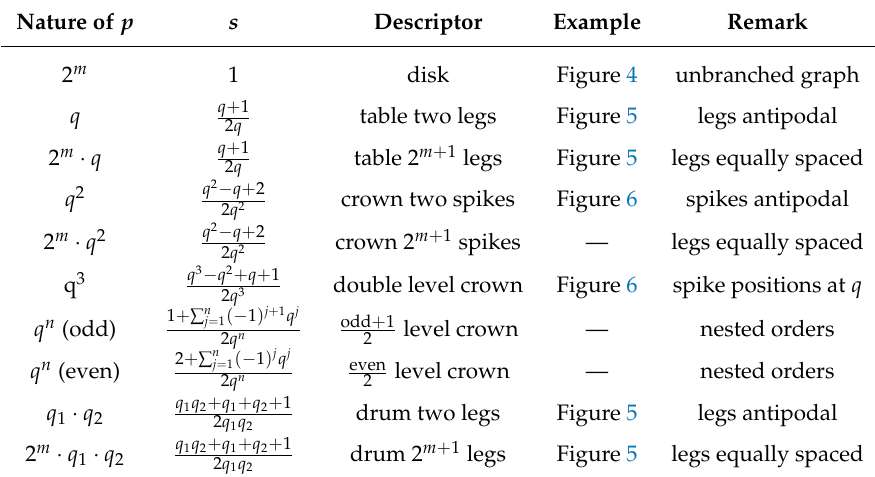
Figure 4 table two legs Figure 5 table 2 m + 1 legs Figure